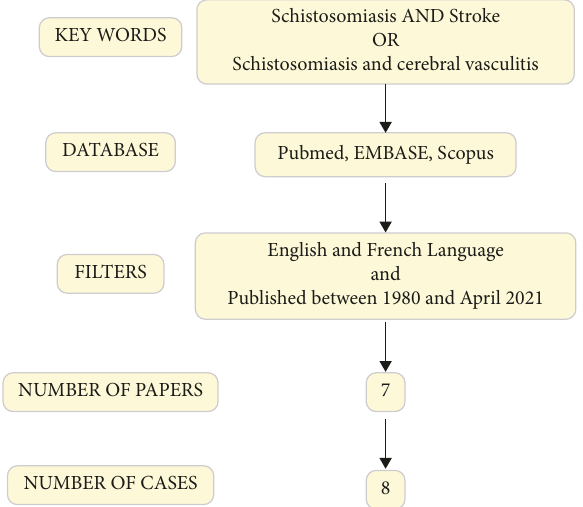
Figure 1: Review of literature from research strategy to number of papers included in the